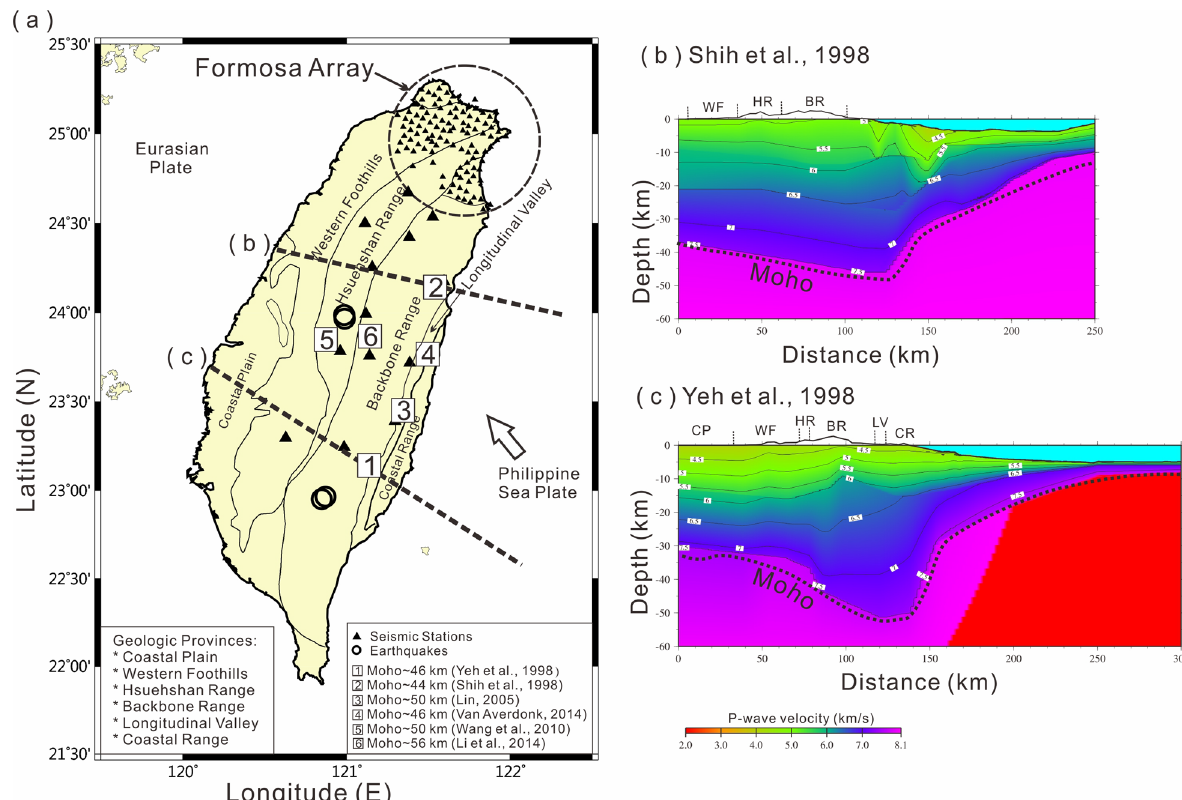
Fig. 11 Comparison of Moho‑depths between this study and some previous results. a Geological provinces and locations of both the Formosa Array and some BATS seismic stations in Taiwan. Locations of the deepest crustal thickness were obtained from previous studies (Number 1–6). Dashed lines with arrows show the crustal thickness obtained in this study along the representative paths of Moho‑refractions beneath the Backbone Range and Hsuehshan Range. b , c are velocity profiles obtained from Shih et al. (1998) and Yeh et al. (1998b),